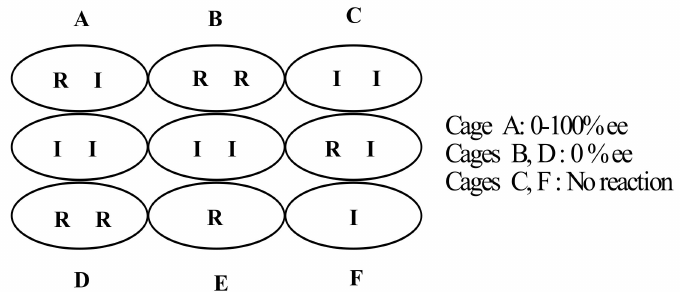
Figure 2. Likely distribution of chiral inductor and reactant molecules within the supercages of X and Y zeolites. Supercages are indicated as elongated oblongs. Several types of occupancies are indicated. Six types of occupancies are labeled as